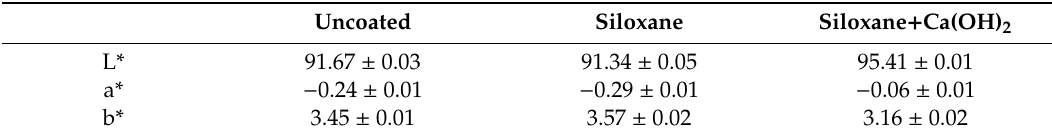
Table 1. Color coordinates measured for uncoated marble and marble specimens coated with siloxane and siloxane + Ca(OH) 2 . The composite coating was prepared using 3 % w / w Ca(OH) 2